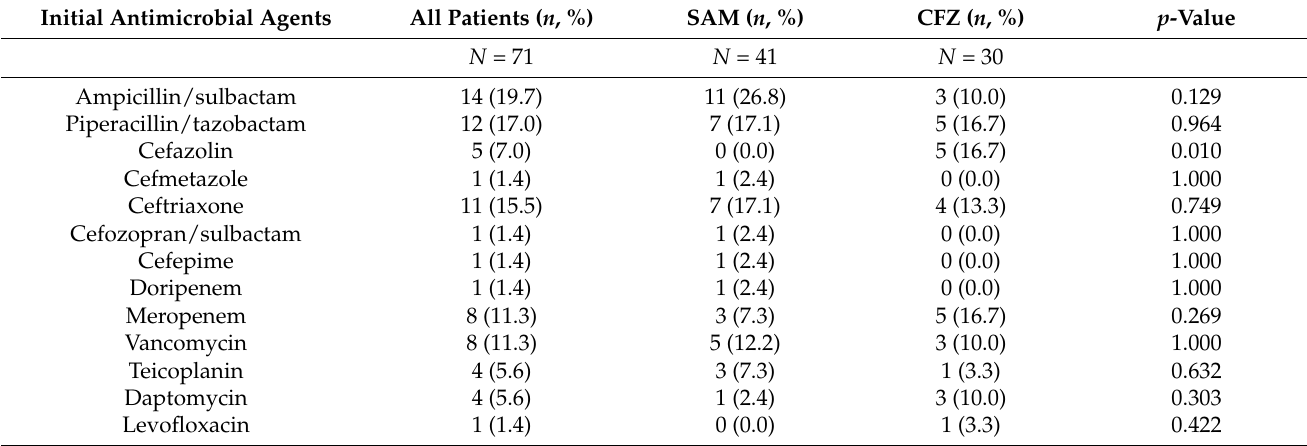
Table 2. Initially administered antibiotics for beta-lactamase-producing MSSA in this study population. Initial Antimicrobial Agents All Patients ( n , %)